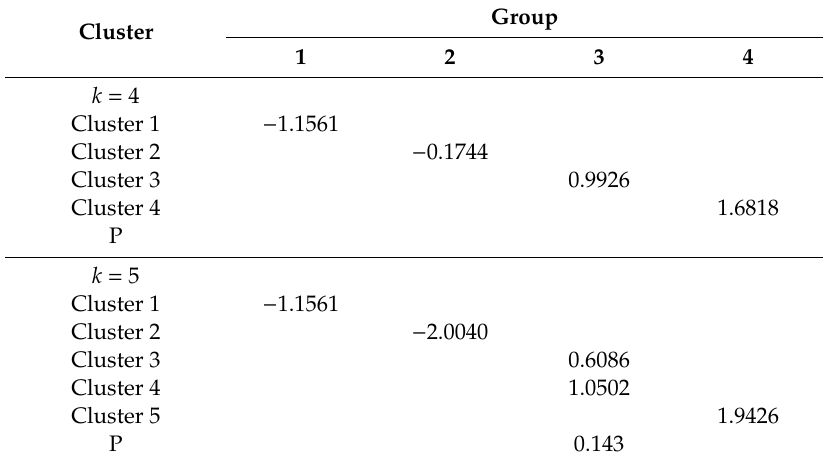
Table 1. Results of Tukey’s test when k = 4 and 5 with the significance level of 0.05.